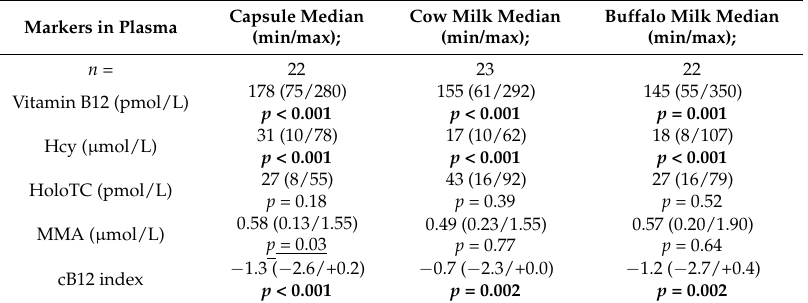
Table 2. End-point measurements of B12 related biomarkers after intervention with B12 present in capsules, cow milk, or buffalo milk and their comparison to baselines 1 .